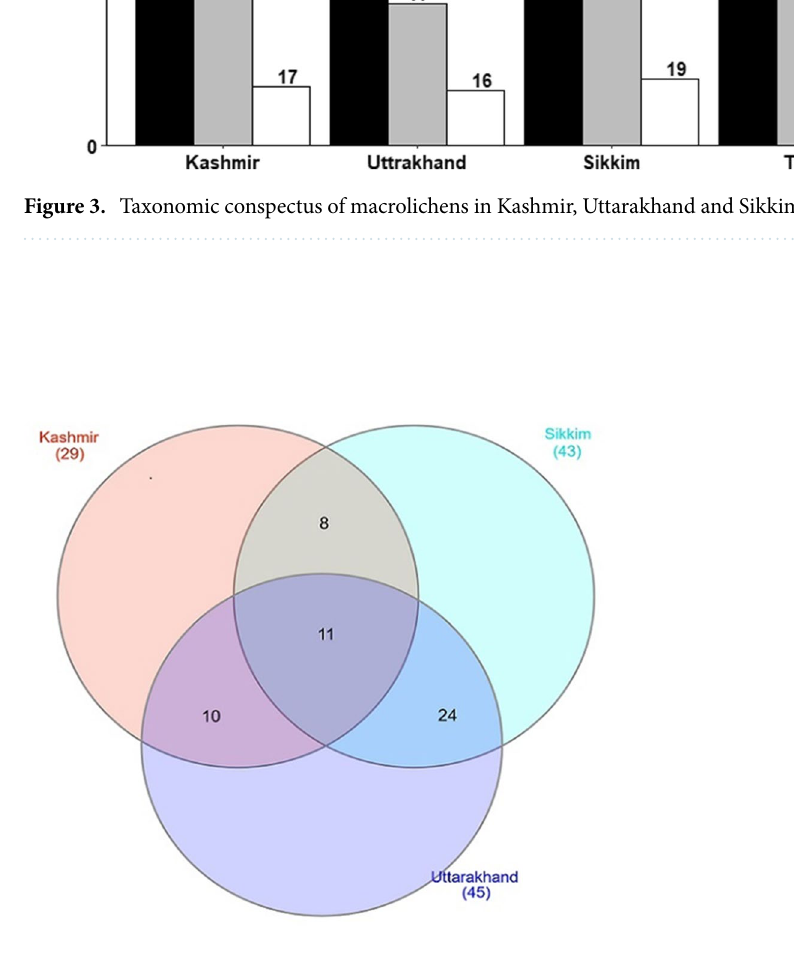
Figure 4. Venn diagram showing the number of lichen species shared between the three